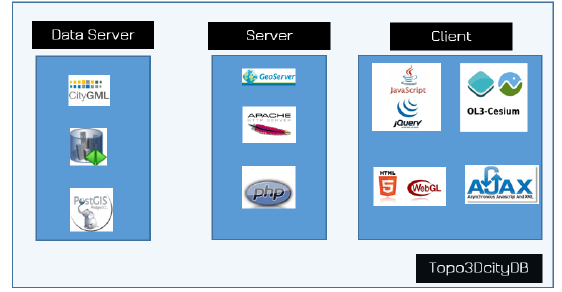
Figure 1. Server-side and Client-side technologies